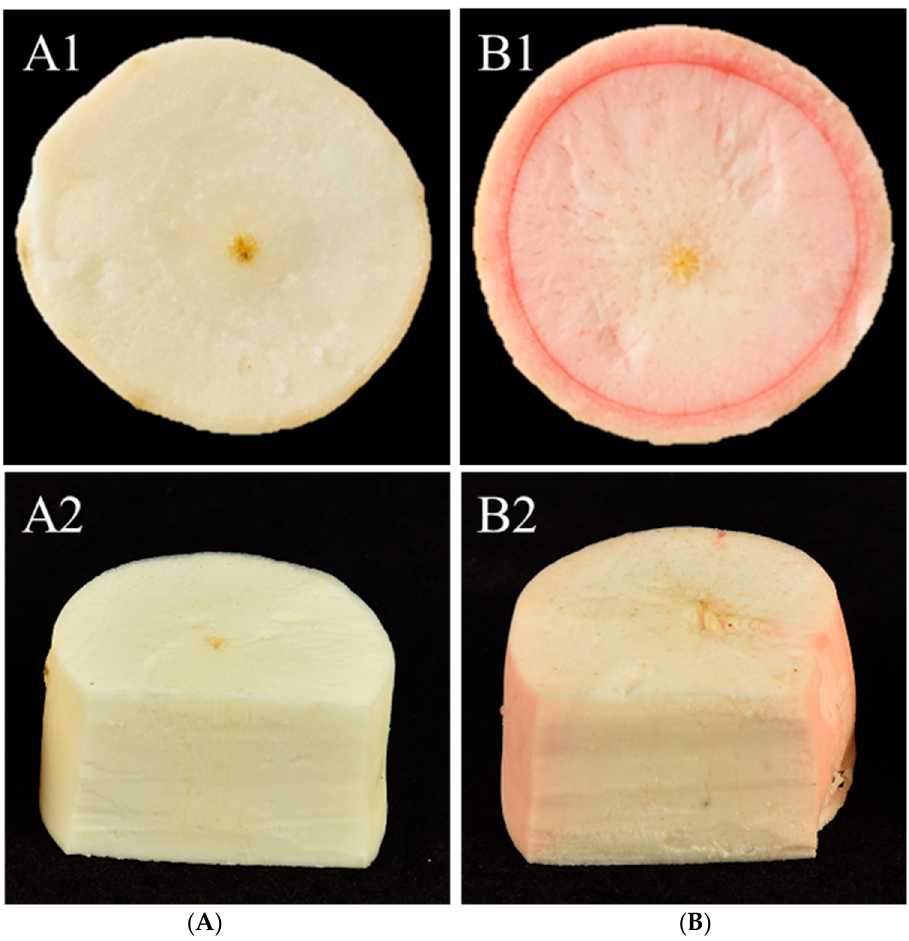
Figure 1. Phenotypes of SC and PC. ( A ) The white flesh of cassava storage roots; ( B ) The pink flesh of cassava storage roots. SC: M. esculenta Crantz cv. sugar cassava GPMS0991L; PC: M. esculenta Crantz cv. pink cassava BRA117315. ( A1 , B1 ) shows the of transverse section SC and PC, ( A2 , B2 ) shows the longitudinal section of SC and PC. Table 1. Measurement of total starch, sucrose, glucose, and fructose of storage roots in different cassava